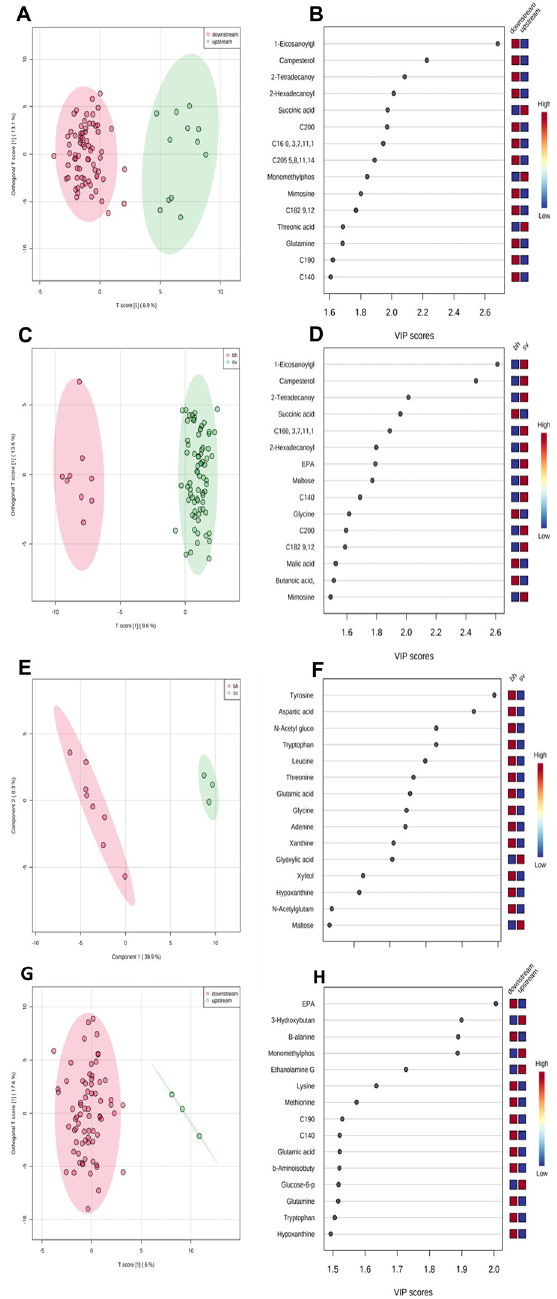
Fig 1. Metabolic patterns in Bigheaded carp with location and species. (A and G) The PLS-DA scores plot’s green and red dots represent upstream and downstream samples, respectively. (A) includes all species (R2 = 0.91; Q2 = 0.69) whereas (G) examines only silvers across location (R2 = 0.514; Q2 = 0.334). In (C) and (E) the green and red dots represent bighead and silver carp, respectively. (C) Examines the metabolites signatures between the Bigheaded carp species (silver carp Hypophthalmichthys molitrix and bighead carp H . nobilis ) (R2 = 0.95; Q2 = 0.79). (E) Examines both carp species in the upstream/leading edge, one sample was omitted, fish 93, as it was classed as an outlier (R2 = 0.99; Q2 = 0.84). Figs B, D, F and H in the panel are variable importance in projection (VIP) scores for the top 15 metabolites form the previous PLS-DA plot. Metabolites with values > 1.0 were considered important contributors. Higher value of the VIP scores indicates an increased contribution of the metabolite to the location separation. The blue and red boxes indicate whether metabolite concentrations increased (red) or decreased (blue) in livers of fish. Note all analyses excluded fish from May 22 nd ,